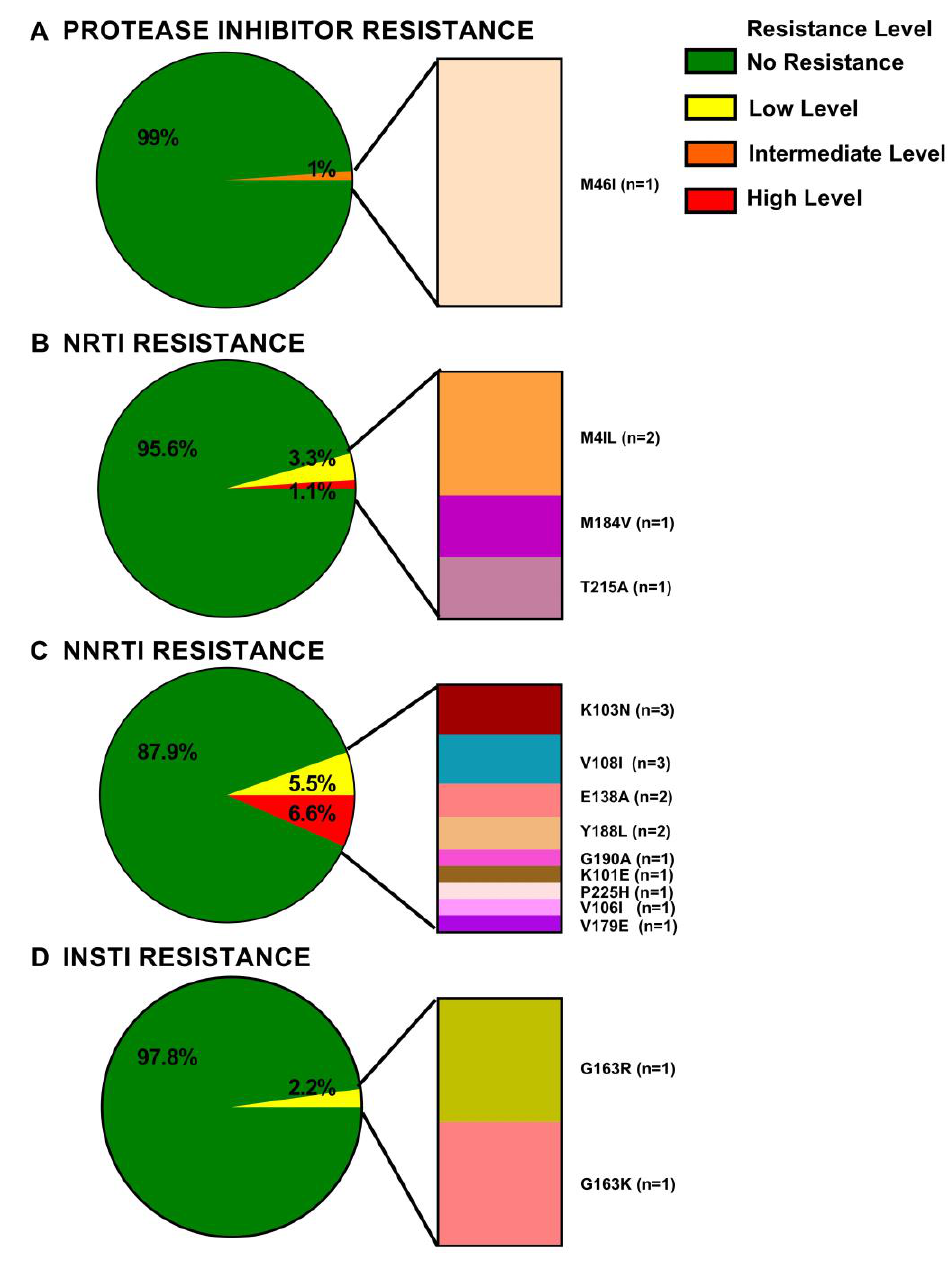
Figure 9. Drug resistance by antiretroviral class, identified by Sanger sequencing. Resistance cate- gories were defined based on the following Stanford scores: Susceptible 0–14, Low-level resistance 15–29, Intermediate resistance 30–59 and High-level resistance ≥ 60. For sequences harboring low, intermediate, or high-level resistance, the individual mutations contributing to the inferred resistance are shown at the right of the pie. Panel ( A ): PI resistance. Panel ( B ) NRTI resistance. Panel ( C ) NNRTI resistance. Panel ( D ) INSTI.